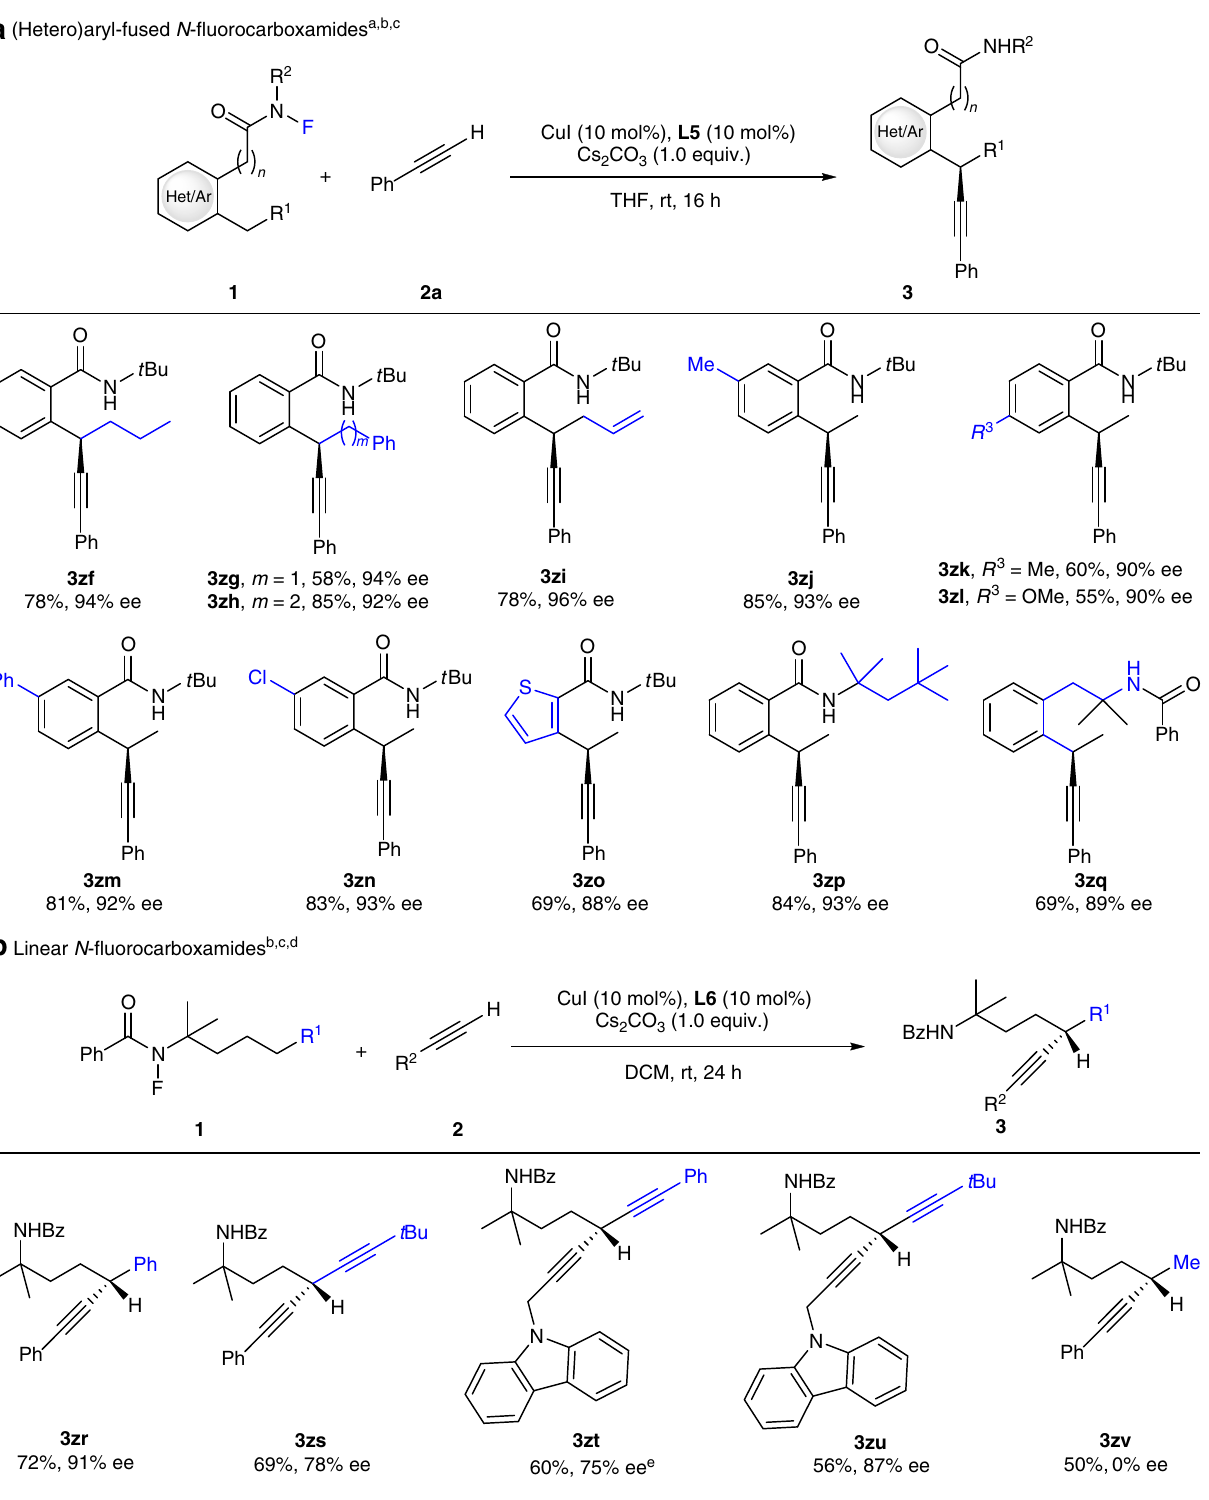
Fig. 3 Substrate scope of N - fl uorocarboxamides. a The reaction is compatible with a variety of (hetero)aryl-fused N - fl uorocarboxamide substrates. b Linear N - fl uorocarboxamides are also applicable under slightly modi fi ed conditions. a Standard conditions: 1 (0.2mmol), alkyne (0.4mmol), CuI (10mol%), L5 (10mol%), and Cs 2 CO 3 (1.0 equiv.) in THF (2.4mL) at rt for 16h. b Isolated yield based on 1 . c Ee values based on HPLC analysis. d L6 (10mol%) was used in DCM at rt for 24h. e L7 (Table 1, 10mol%) was used in CHCl 3 at rt for